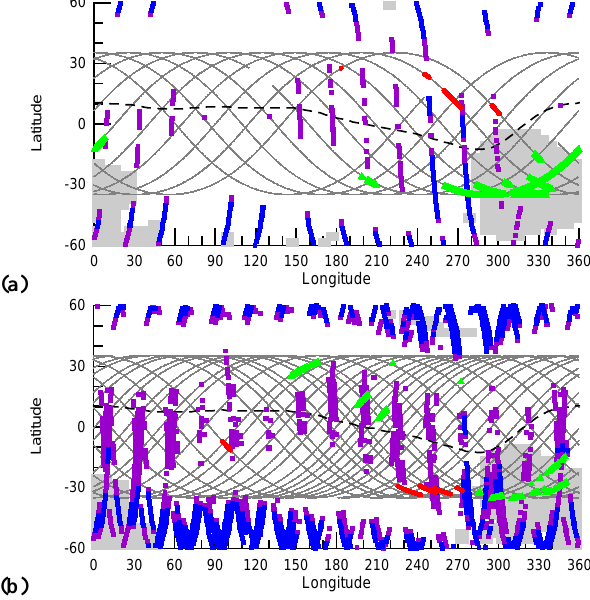
Fig. 9. Significant enhancements of the ion density observed by the ROCSAT-1/IPEI in the dayside (red circles) and in the nightside (green triangles) hemispheres, and energetic particle enhancements (squares) observed by the SAMPEX/LEICA at altitudes ∼ 600km during the Bastille (a) and Halloween (b) geomagnetic storms. The orbit of ROCSAT-1 during those disturbed periods is shown by gray dotted line. The relative enhancements of particle fluxes of rI > 1.3 and rI > 10 are indicated, respectively, by violet and blue squares. For reference, gray areas depict the regions of strong back- ground particle fluxes (including SAA) with quiet-time intensities of > 100cm − 2 s − 1 sr − 1 . Thick dashed line indicates the geomag- netic equator. Most of the ionospheric ion density enhancements are overlapped with the regions of enhanced energetic particle